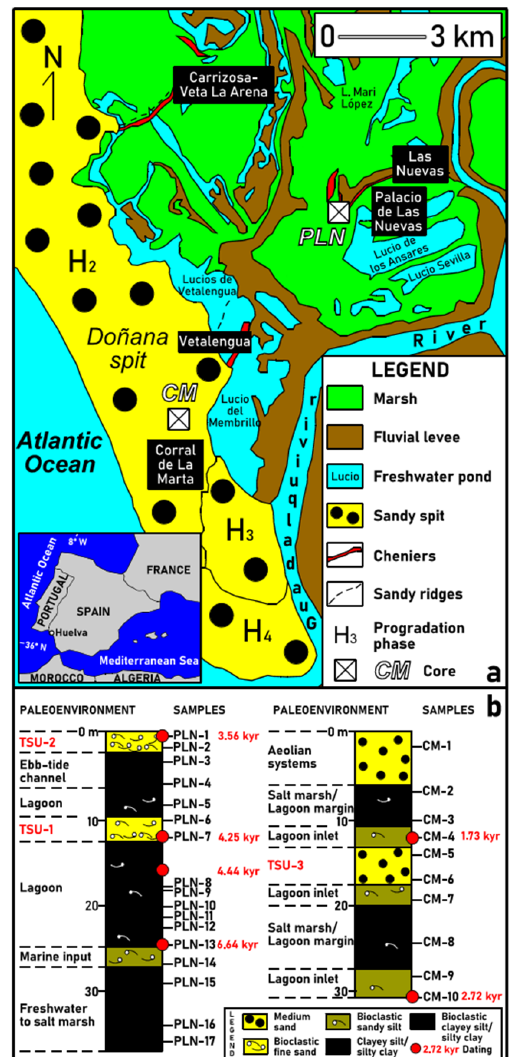
Figure 2. ( a ) Synthetic geomorphological map of the Doñana National Park; ( b ) Paleoenvironmental reconstruction of the cores PLN [19] and CM [20], including samples and radiocarbon dating from these references.